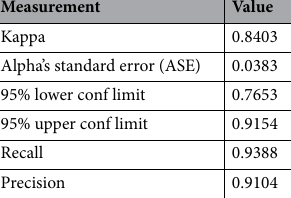
Table 8. Cohen’s kappa coefficient, recall and precision results for the multi-lameness classifiers.